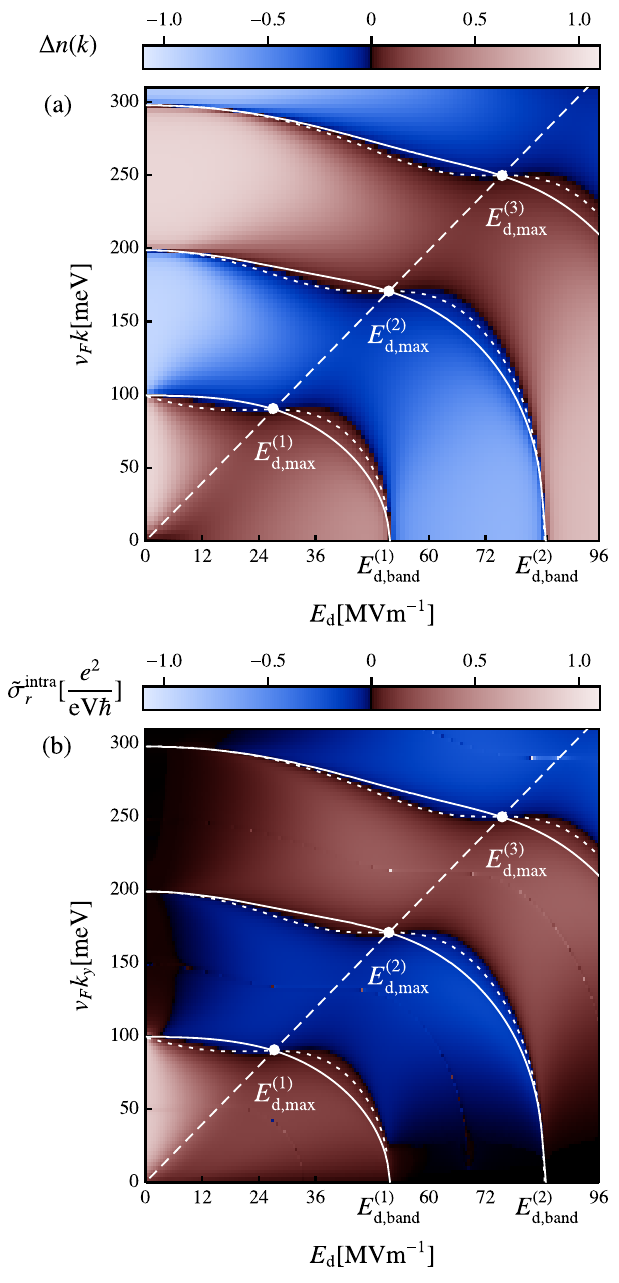
Fig. 5 Effective Floquet state occupation and intra-Floquet conductivity. The effective occupation Δ n ( k ) ( a ) and the fi tted intra-Floquet conductivity ~ σ intra ð k y Þ ( b ) as functions of the fi eld strength E d . The solid white lines are r given by the locations in momentum space of the band gaps Δ m , with m > 0. The dotted white lines are given by the zero-crossings of a type of comoving band velocity ∂ Π Δ ϵ = 0, where Π = v F ( k + E d / ω d ) (See Supplementary Note 1). The dashed line is given by k ¼ E d ω